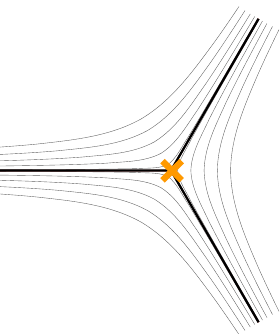
Figure 8 . The local structure of the WKB foliation for N=2 around a branch point of e C → C . The branch point is represented by an orange cross. The dark lines represent critical leaves, while the lighter lines are generic leaves.